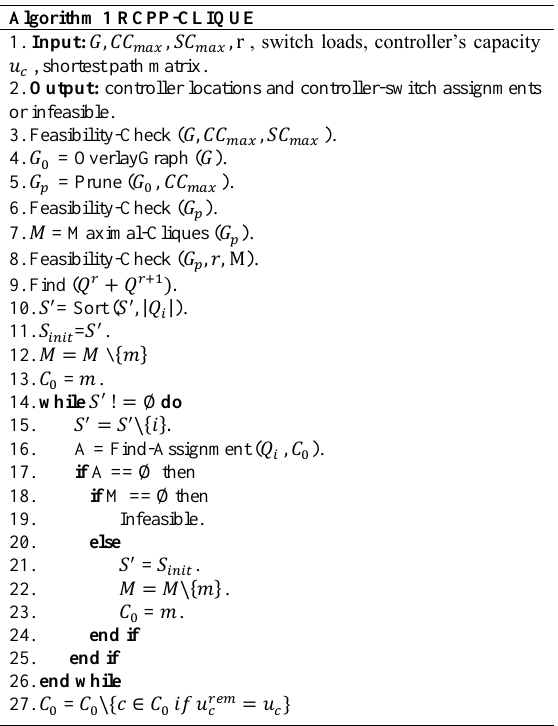
Algorithm 1 RCPP-CLIQUE 1. Input: 𝐺,𝐶𝐶 𝑚𝑎𝑥 ,𝑆𝐶 𝑚𝑎𝑥 ,r , switch loads, controller’s capacity 𝑢 𝑐 , shortest path matrix. 2. Output: controller locations and controller-switch assignments